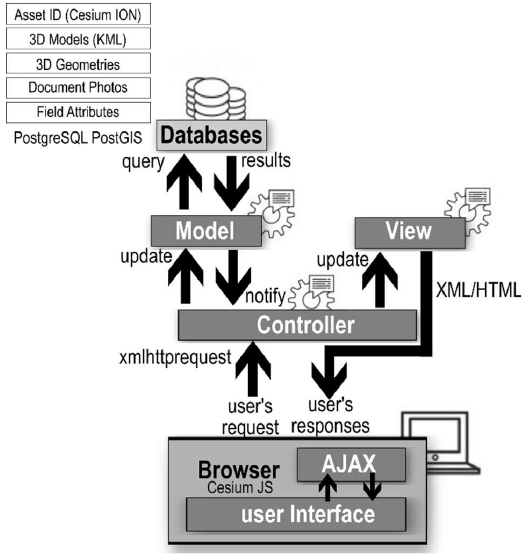
Figure 7. Schematic view of the Model-View-Controller (MVC) pattern’s use.